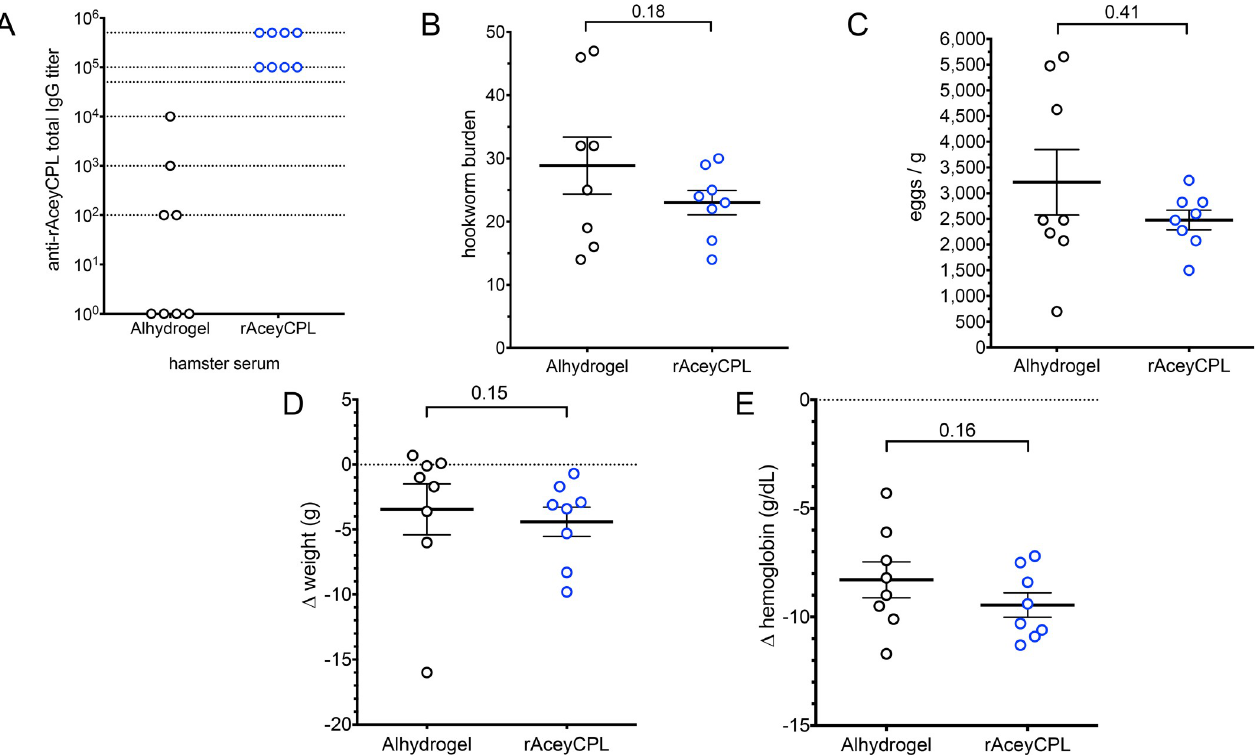
Fig 3. rAceyCPL/Alhydrogel vaccine trial. (A) rAceyCPL serum IgG titers in Alhydrogel controls and rAceyCPL/Alhydrogel vaccinates. Dotted lines indicate the inverse of serum dilutions tested. (B) Comparison of mean hookworm burden between rAceyCPL/Alhydrogel and Alhydrogel control vaccinates. (C) Comparison of mean FECs between rAceyCPL/Alhydrogel and Alhydrogel control vaccinates. (D) Comparison of mean change in weight after hookworm infection between rAceyCPL/Alhydrogel and Alhydrogel control vaccinates. (E) Comparison of mean change in hemoglobin concentration after hookworm infection between rAceyCPL/Alhydrogel and Alhydrogel control vaccinates. Numbers above bars indicate P values for comparison. (B-E) Error bars here and all figures indicate standard error.